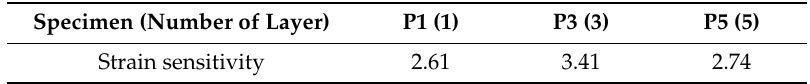
Table 4. Strain sensitivity of the maximum light absorption of the corrugated P3HT:PCBM thin film specimens during loading cycle